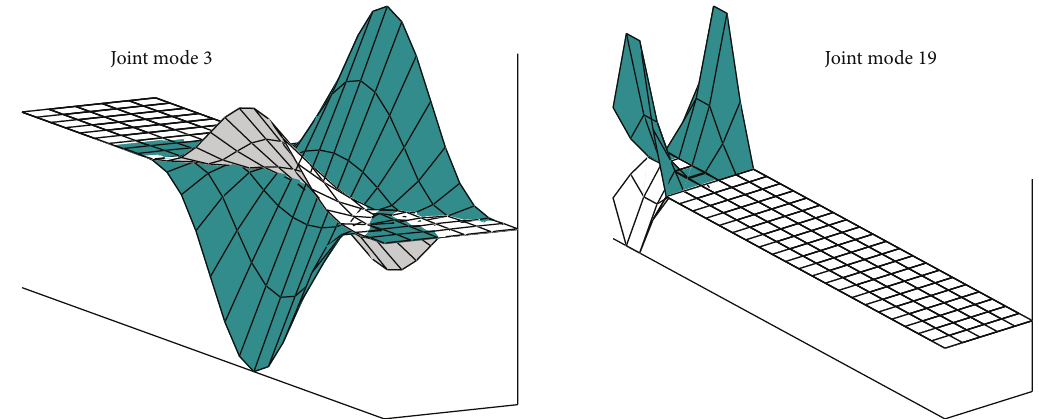
Figure 20: Joint mode numbers 3 and 19 following